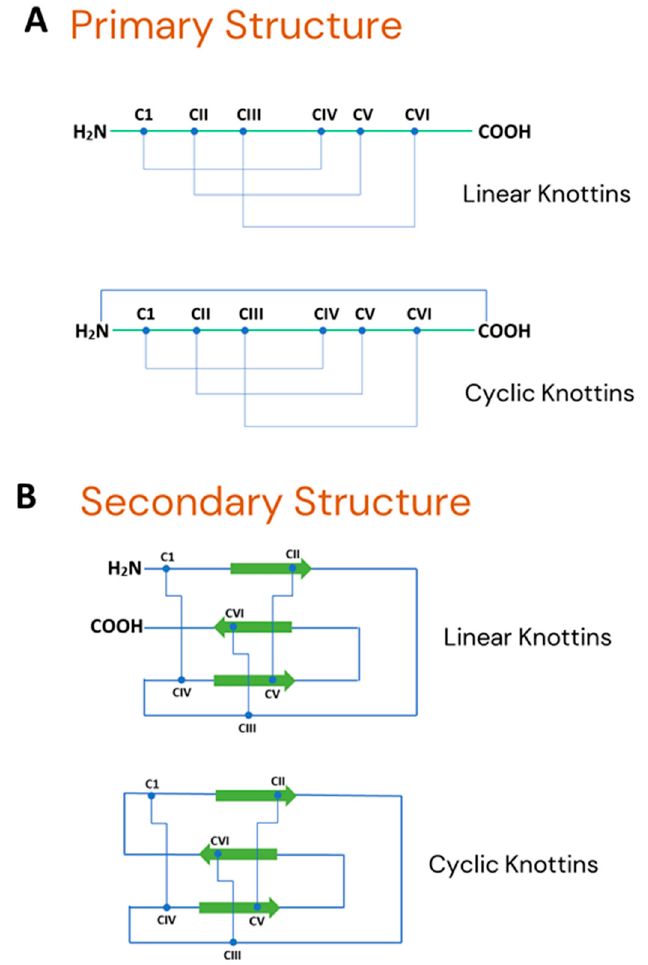
Figure 1. Representative primary and secondary structures of cystine knot peptides (knottins): ( A ) Primary structure showing diagnostic intercysteine connectivity as well as free N- and C-termini for linear knottins and connected termini without free amino and carboxyl termini expressed naturally by cyclic knottins; ( B ) Secondary structural backbone showing antiparallel sheet stabilized by a cystine knot. Strands are shown in orange and the six cysteine residues that form the cystine knot are labeled 1–6. While the disulphide bonds are known to be responsible for the extremely stable nature of knottins, the continuous circular configuration in cyclic knottins additionally makes the N- and C-termini unavailable for attacks by external digestive agents.